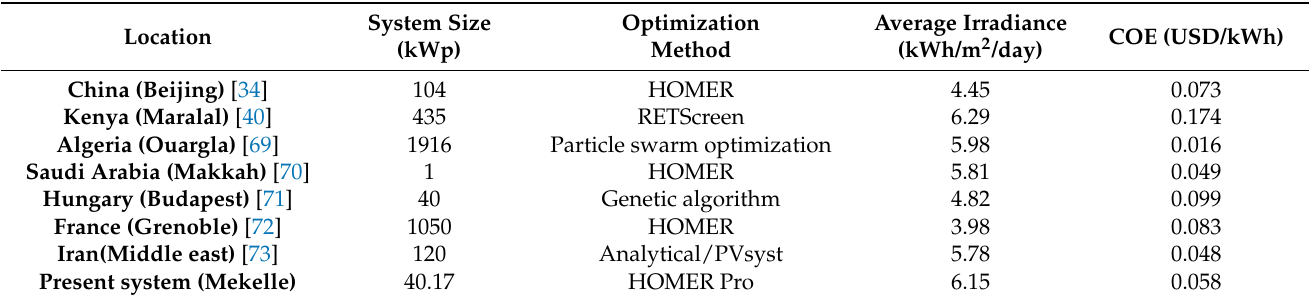
Table 8. Comparison of the present system’s configuration with other studies.